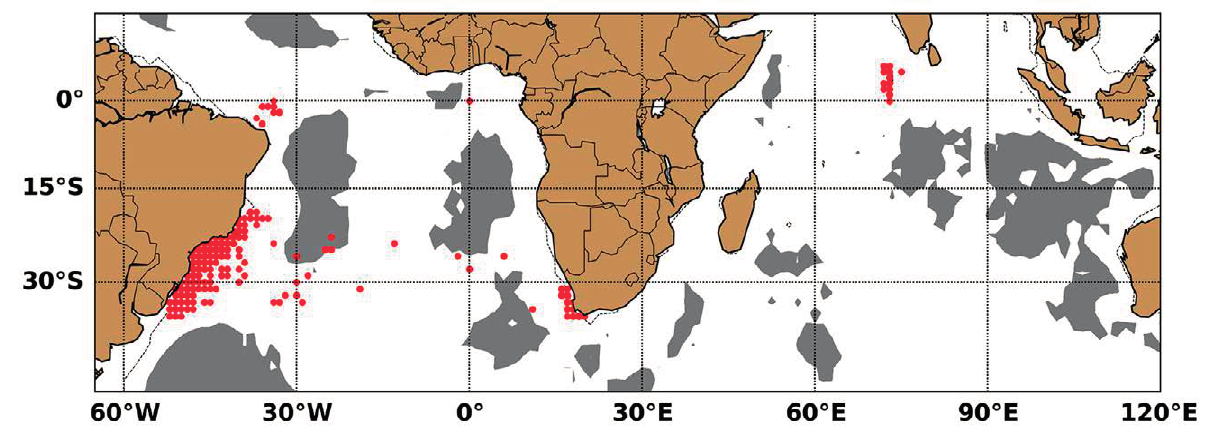
Fig. 1. – Pole-and-line skipjack fishing events (in red) off BR, SA and the MA (data sourced from ICCAT 2014a, IOTC 2016). The dotted line indicates the 200 m isobaths; the grey areas correspond to depths greater than 4000